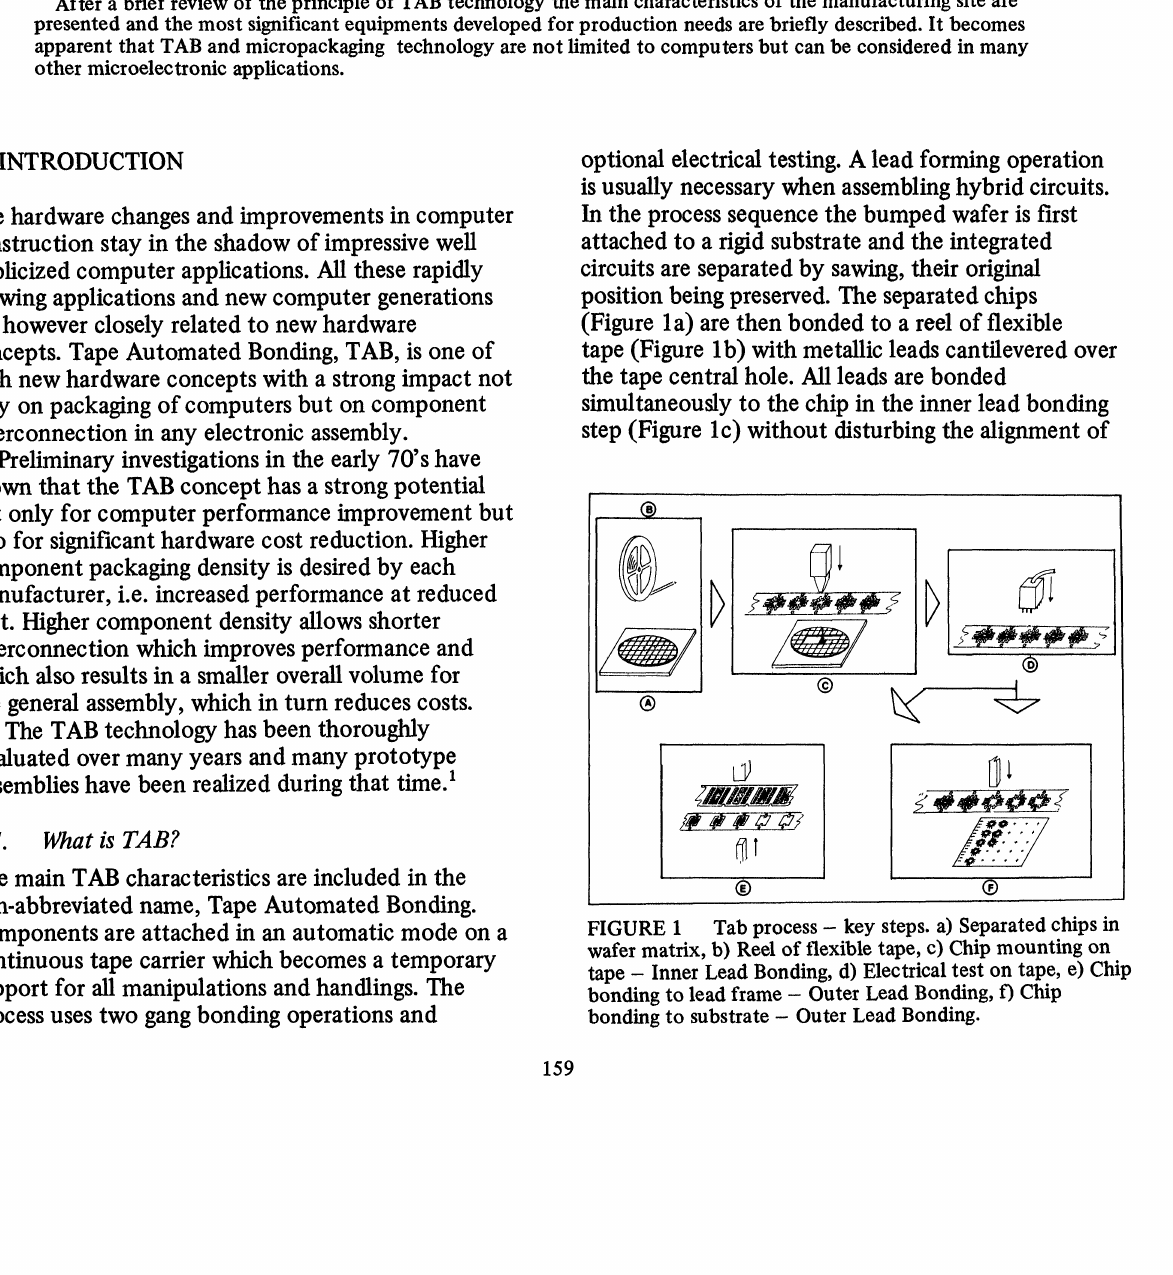
Tab process key steps, a) Separated chips in wafer matrix, b) Reel of flexible tape, c) Chip mounting on tape Inner Lead Bonding, d) Electrical test on tape, e) Chip bonding to lead frame Outer Lead Bonding, f) Chip bonding to substrate Outer Lead